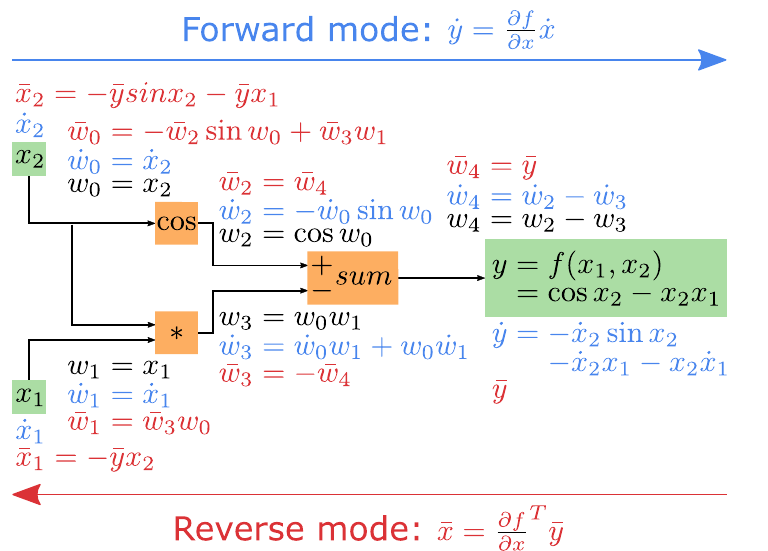
Fig 1. Example of AD forward and reverse modes. A function y = f ( x 1 , x 2 ) = cos x 2 − x 2 x 1 is broken down into a sequence of elementary operations, forming an expression graph. In the forward mode, the forward seeds _ x propagated from the inputs to the output, and the Jacobian J = @ f / @ x relates _ x the reverse mode, the reverse seed � y is propagated from the output to the inputs, and the transposed Jacobian J T relates � y to the reverse sensitivities � x and � x 1 2